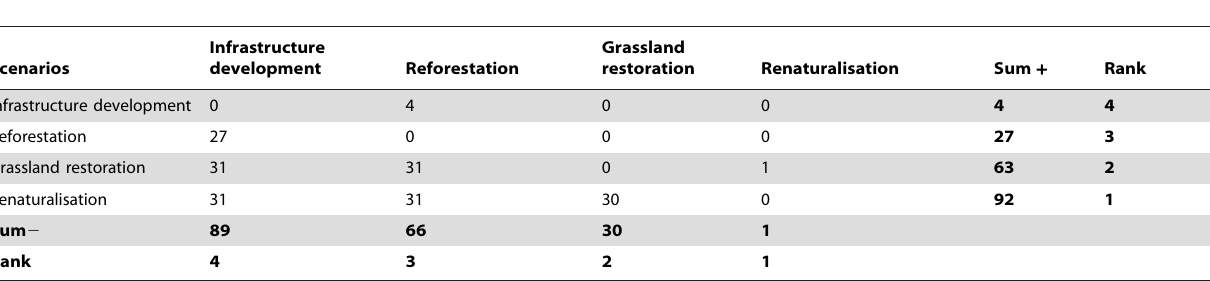
Table 4. Total preference matrix summarising results of metapopulation dynamics sensitivity